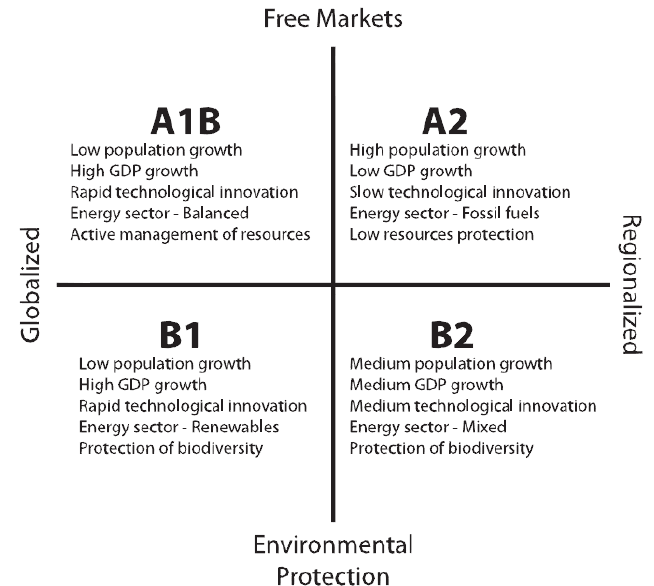
Figure 1. Characteristics of the four scenarios based on major driving forces behind the Intergovernmental Panel on Climate Change’s Special Report on Emission Scenarios